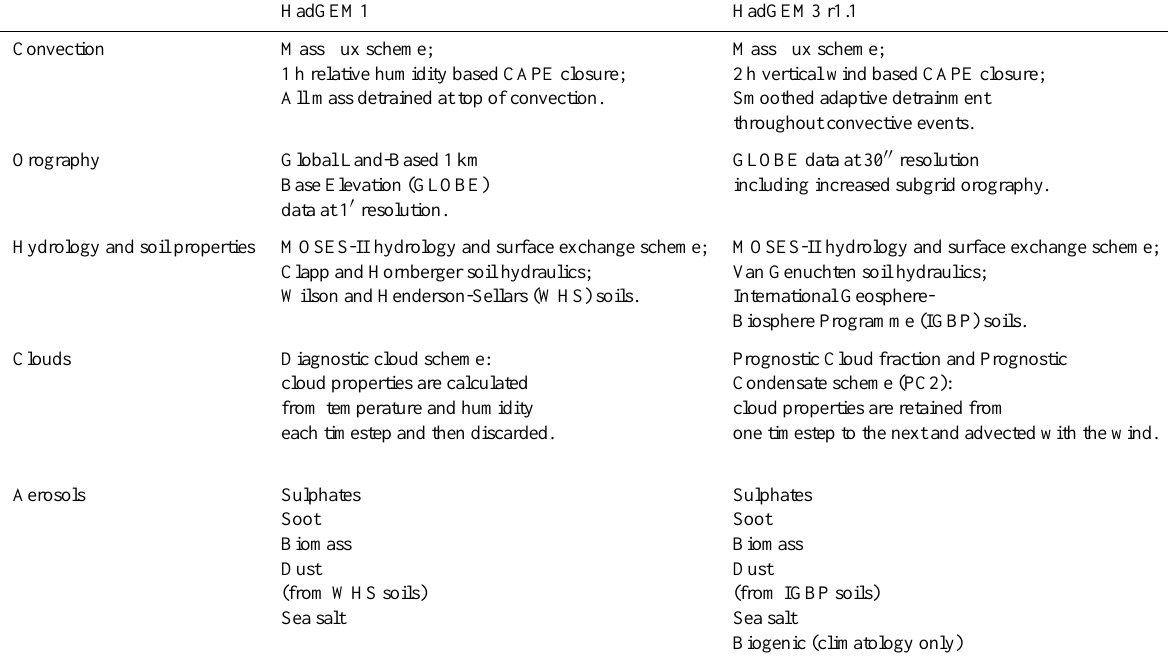
Table A1. Main differences between the atmospheric submodels in HadGEM1 and HadGEM3 r1.1. HadGEM1 HadGEM3 r1.1 Convection Mass flux scheme; Mass flux scheme; 1h relative humidity based CAPE closure; 2h vertical wind based CAPE closure; All mass detrained at top of convection. Smoothed adaptive detrainment throughout convective